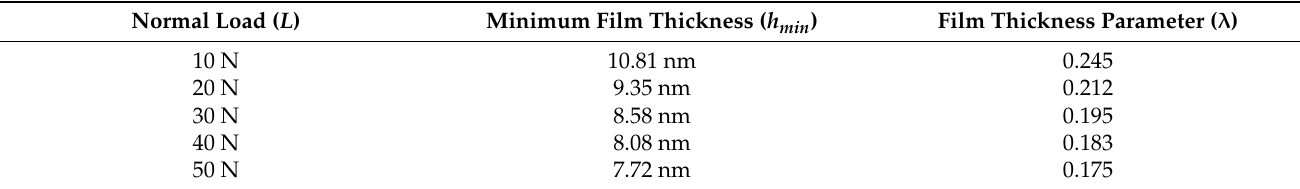
Table 3. Estimated h min and λ values for the applied normal loads. (composite modulus of elasticity, E* = 120.94 GPa; sliding velocity, u = 0.29